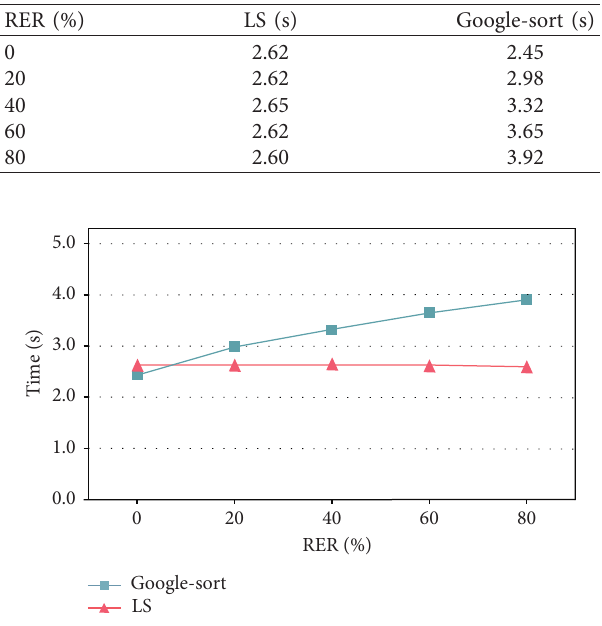
Figure 11: Trends of average time consumptions of LS and Google- sort algorithms with five RERs. The x -axis represents the RER of experimental datasets (%), and the y -axis represents the sorting time in the average case (in